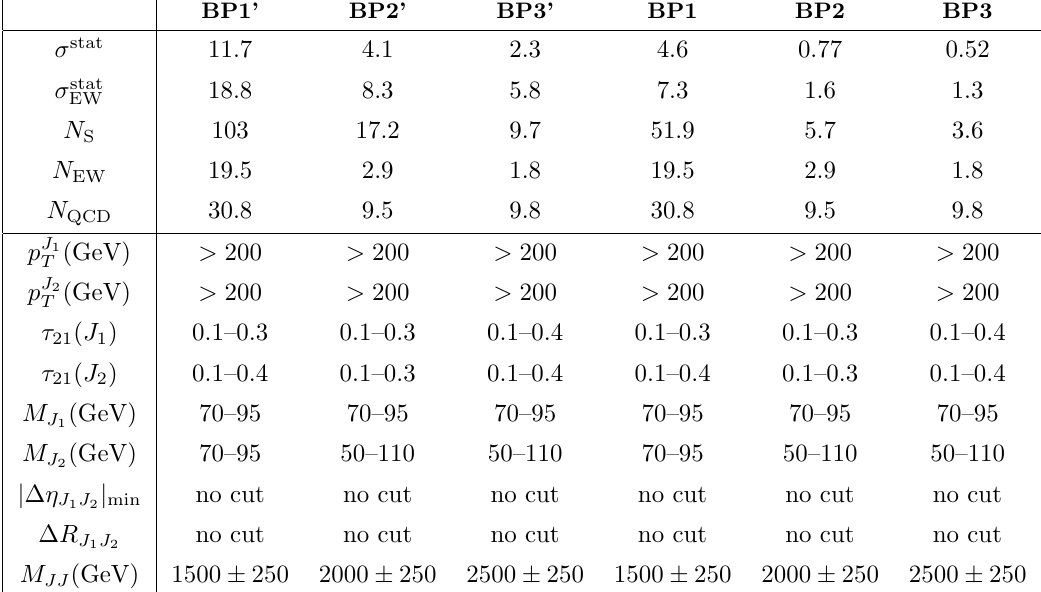
Table 4 . Results for the optimal cuts and the number of predicted events for the various signal scenarios ( N ) given by the BPs and for the SM backgrounds, EW ( N S well as their associated statistical signi(cid:12)cances de(cid:12)ned in eq. (3.6). Here J subleading fat jets respectively. The integrated luminosity is (cid:12)xed to L = 3000 fb (cid:0) 1 . where N , N and N refer to the number of events of the signal, EW background S EW QCD and QCD background, respectively, for a luminosity of L = 3000 fb (cid:0) 1 . Due to the